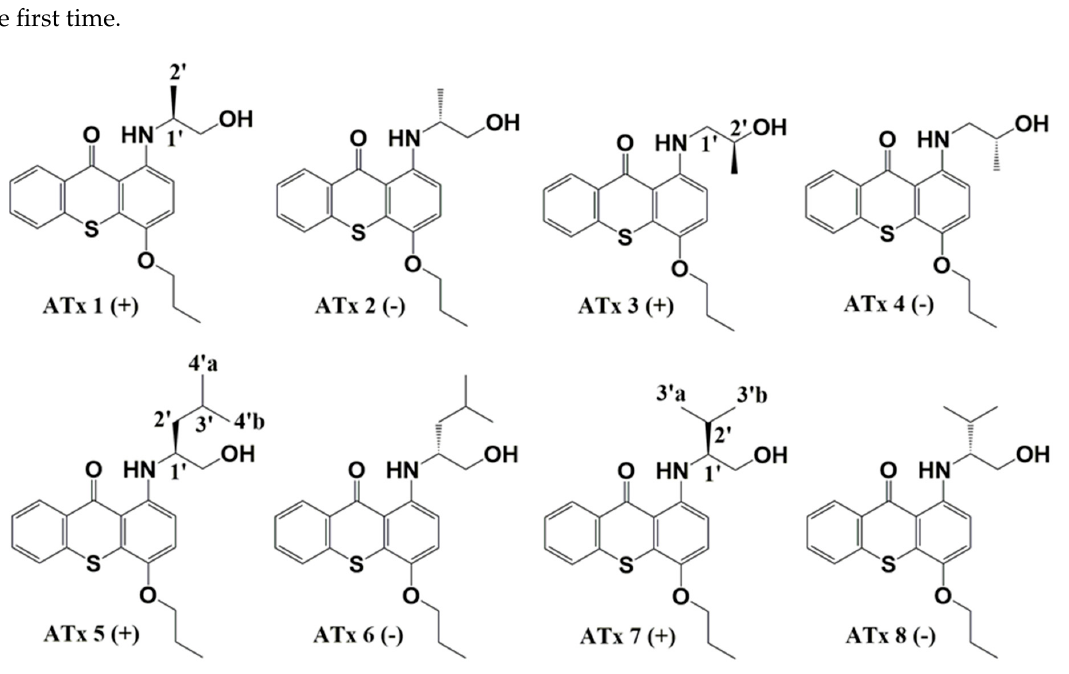
Figure 1. Structures of the studied chiral aminated thioxanthones, ATxs 1 – 8 .